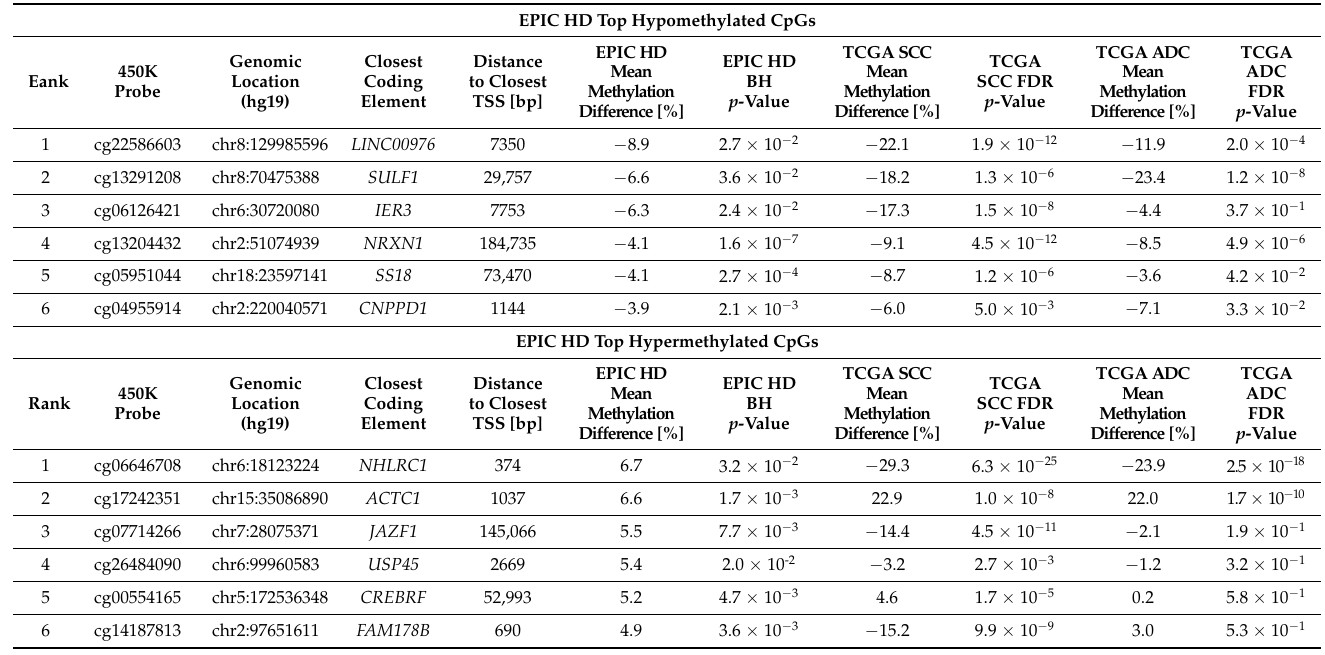
Table 2. Top 1% ( n = 12) of Ranked Hypo- and Hypermethylated CpGs from EPIC HD. BH: Benjamini Hochberg, hg19: human genome assembly 19.